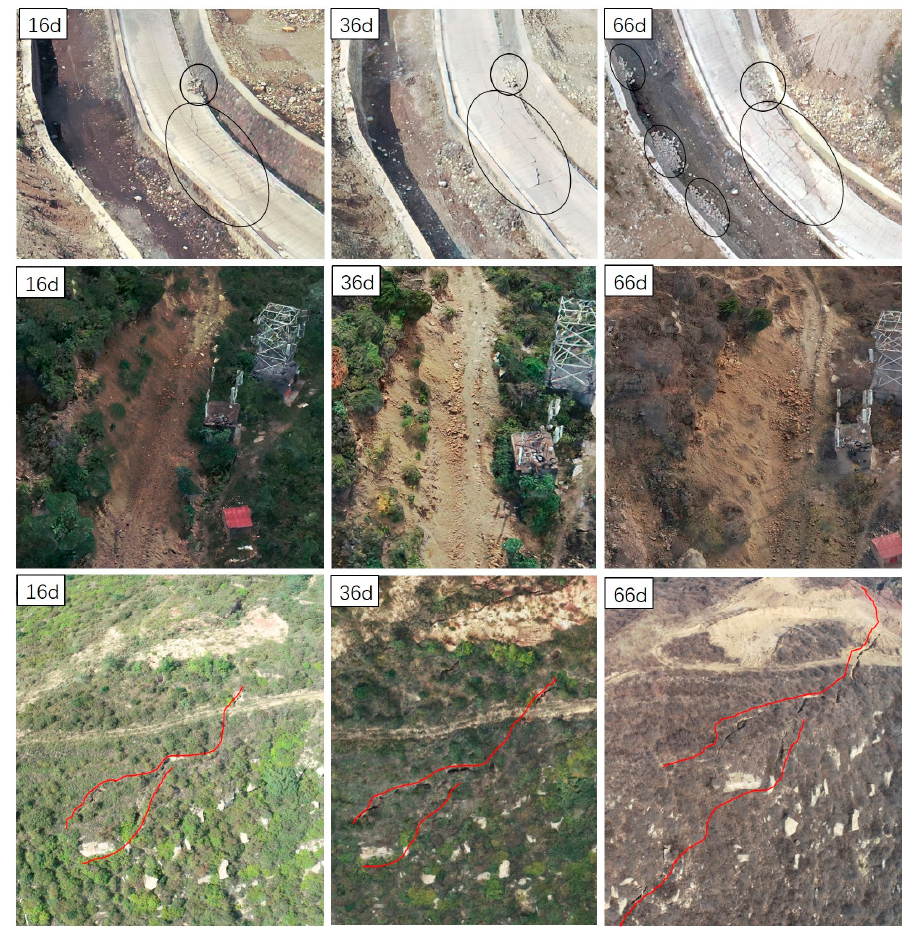
Figure 13. Unmanned Aerial Vehicle (UAV) low-altitude remote sensing time series images of Luhu village landslide.